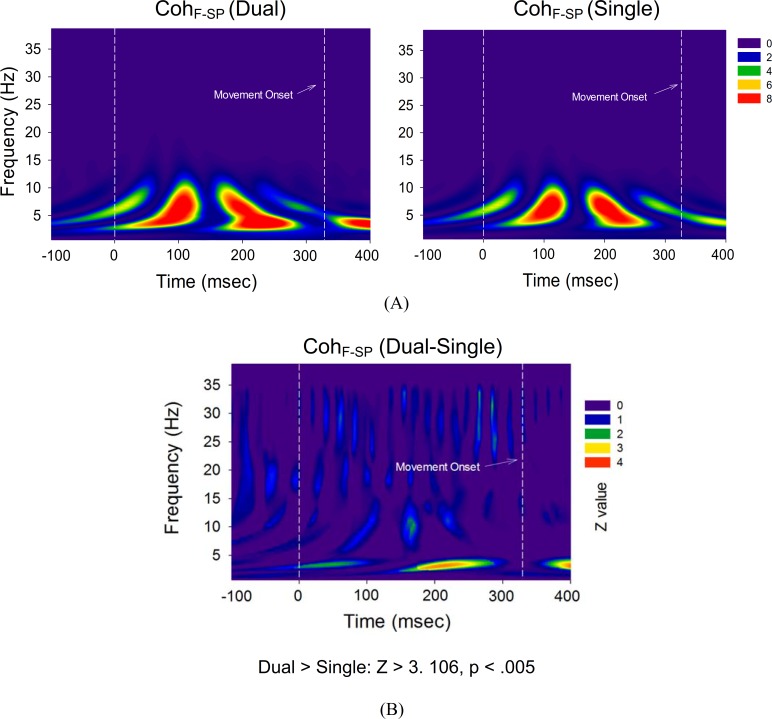
Time-dependent cross-spectra of PC1.(A) Time-dependent cross-spectra between PC1s in the frontal and sensorimotor-parietal areas in the single-posture and dual-task conditions. (B) Normalized task-related differences in time-dependent PC1 cross-spectra in terms of Z values. The dual-task condition exhibited stronger delta coherence between the frontal and sensorimotor-parietal areas in the P2 period (p < .005).